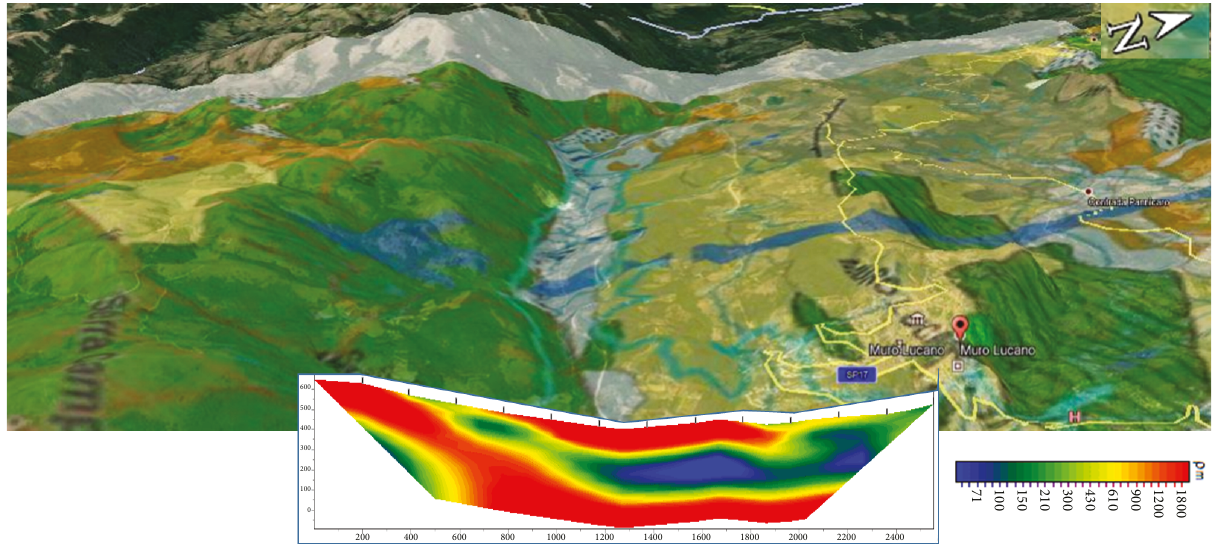
Figure 5: The hydrogeological map on a 3D vision (Google 3D) and the DERT image. The deep was carried out by CNR-IMAA prototype. The RMS is 12.8%.